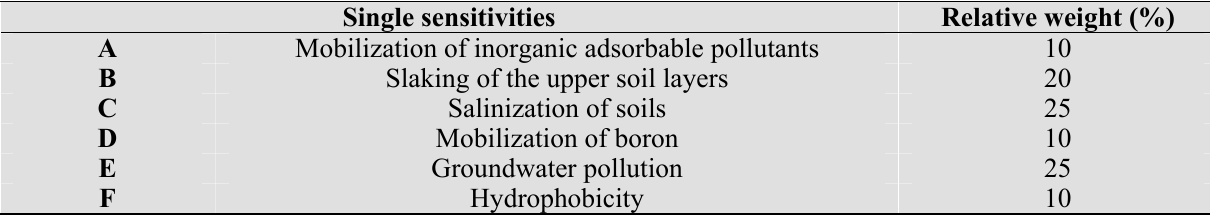
Table 11. Relative weights of the single sensitivities.